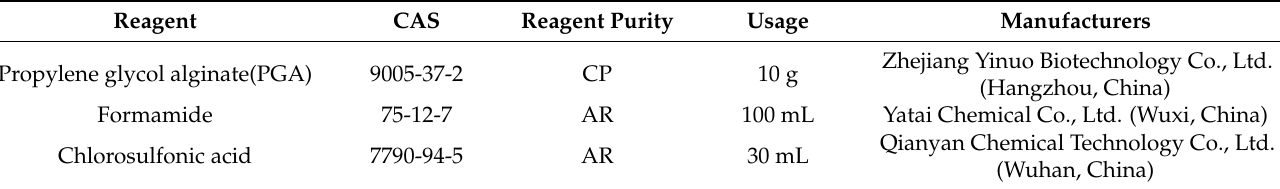
Table 1. Specific information of materials